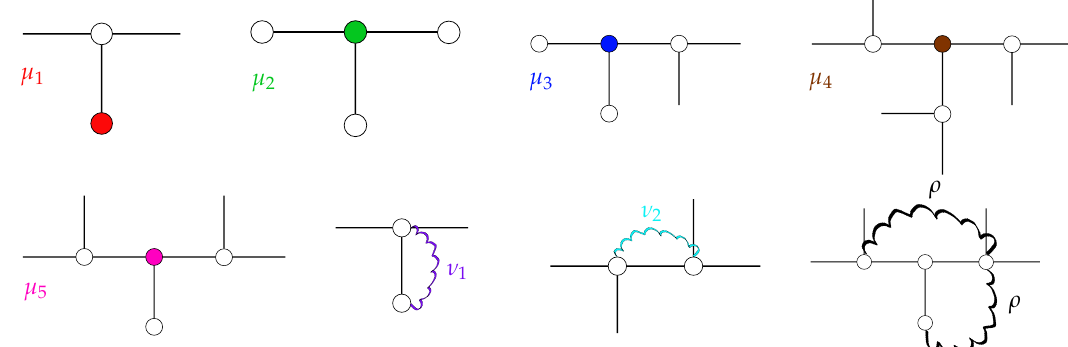
Figure 2. Schematic representation of the non-vanishing elements of matrix A STP . For diagonal elements ( µ i ), the corresponding beads are highlighted by color. For off-diagonal elements ( ν i and ρ ), the corresponding interactions are indicated through wavy lines.